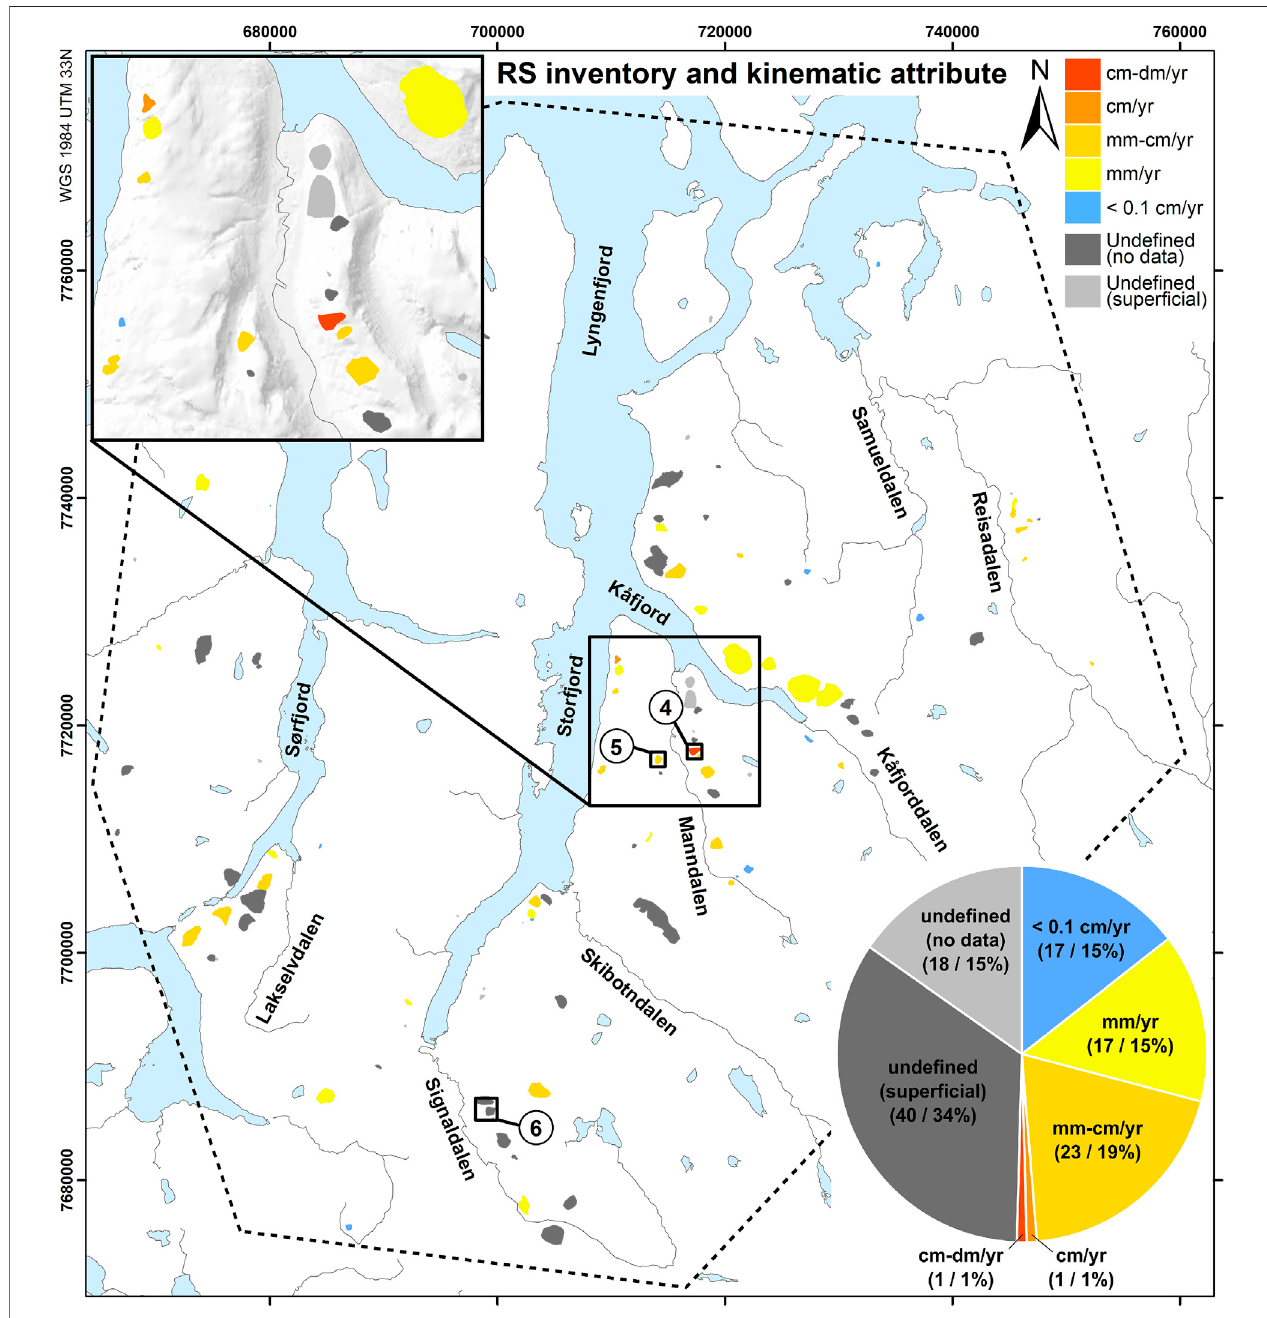
FIGURE 11 | Updated rockslide (RS) inventory consisting of 117 landforms and variability of the kinematic attribute in the study area. Inset map (upper-left corner) : detailed view over an area including several landforms with variable kinematic attributes. Pie chart (lower-right corner) : kinematic attributes for all inventoried RS. Locations 4 – 6 are the examples shown in Figure 10 . Sea, lakes, rivers and reference names from NMA (2020a).